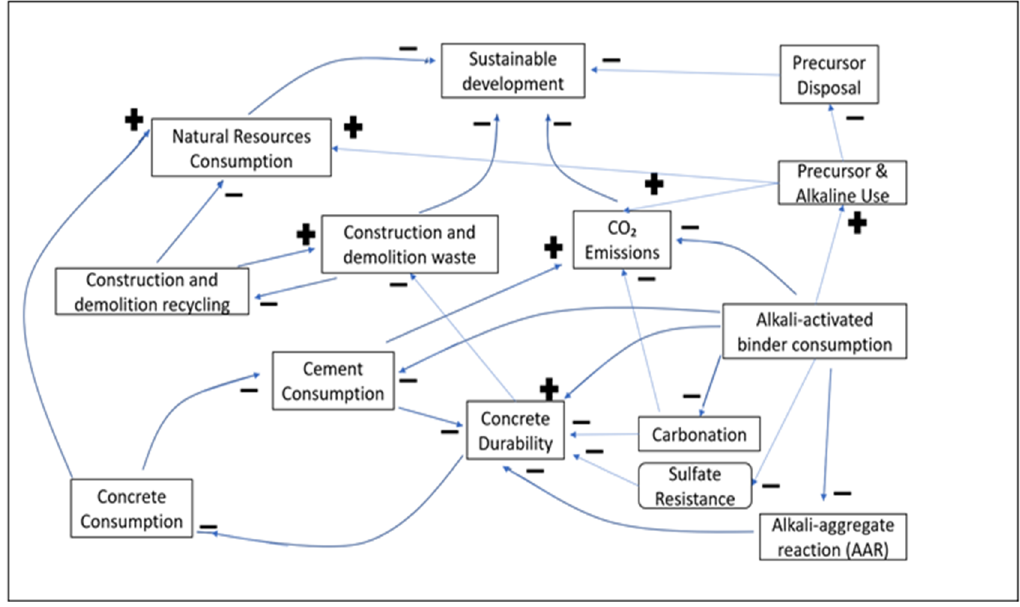
Figure 1. Casual Loop Diagram.